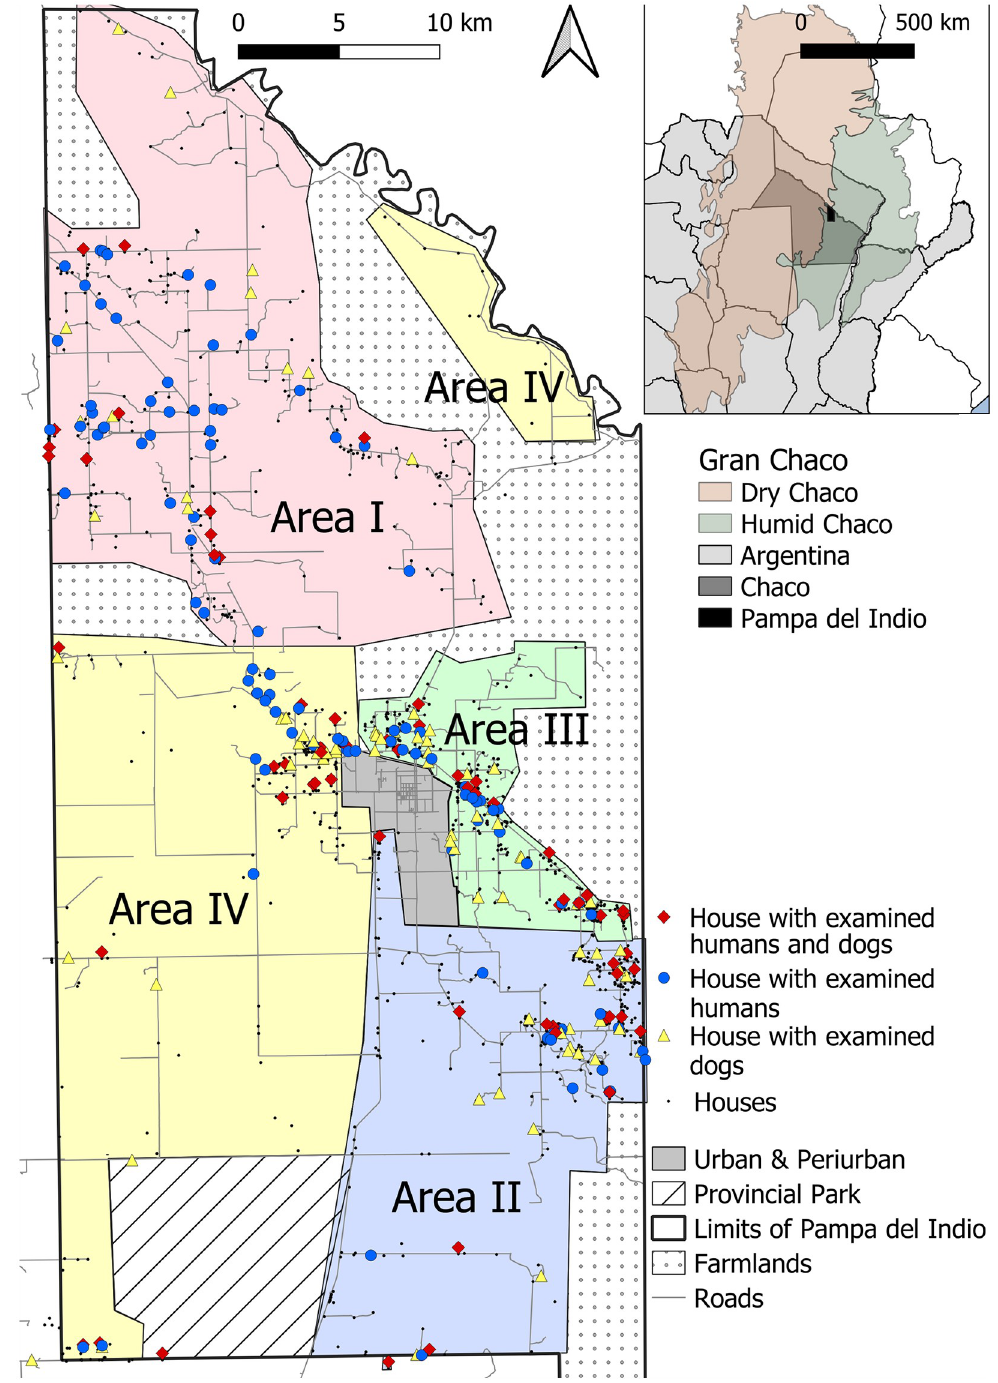
Fig 1. Location of study households included in the human and dog serosurveys. Operational areas are shown as colored-shaded polygons, 2016–2017. Inset shows the location of Pampa del Indio Municipality within the Chaco Province and the Gran Chaco ecoregion. Maps were based on the data collected within the scope of this study and using base layers from Instituto Geogra´fico Nacional (Argentina). Available online: https://www.ign.gob.ar/NuestrasActividades/